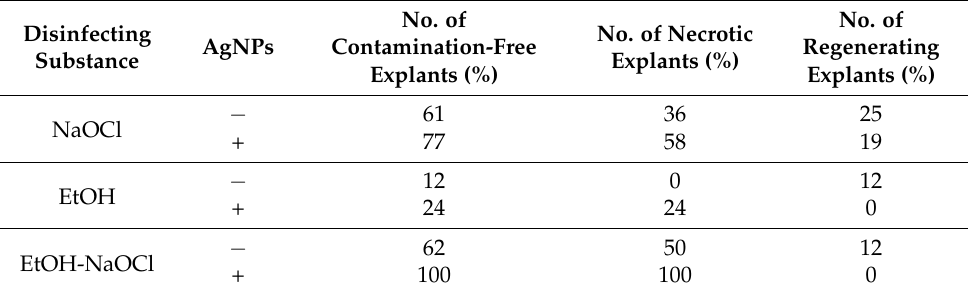
Table 1. The contamination rate and regeneration of Aldrovanda vesiculosa in vitro, depending on the use of sodium hypochlorite (NaOCl) or ethanol (EtOH) for explants disinfection, and the addition of silver nanoparticles (AgNPs) to the 1/5 Murashige and Skoog (MS) culture media. No. of No. of Disinfecting No. of Necrotic AgNPs Contamination-Free Regenerating Substance Explants (%) Explants (%) Explants (%) − 61 36 25 NaOCl + 77 58 19 − 12 0 12 EtOH + 24 24 0 − 62 50 12 EtOH-NaOCl + 100 100